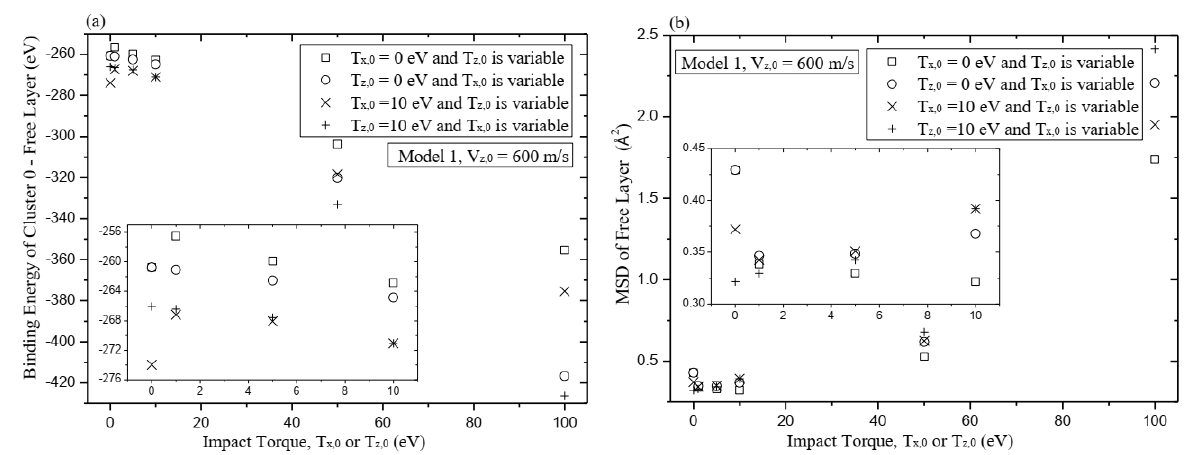
Figure 9. ( a ) Binding energy between Cluster 0 and free layer at the different T x ,0 and T z ,0 . ( b ) MSD of free layer at different T x ,0 and T z ,0 . All cases are in Model 1, and V z ,0 = 600